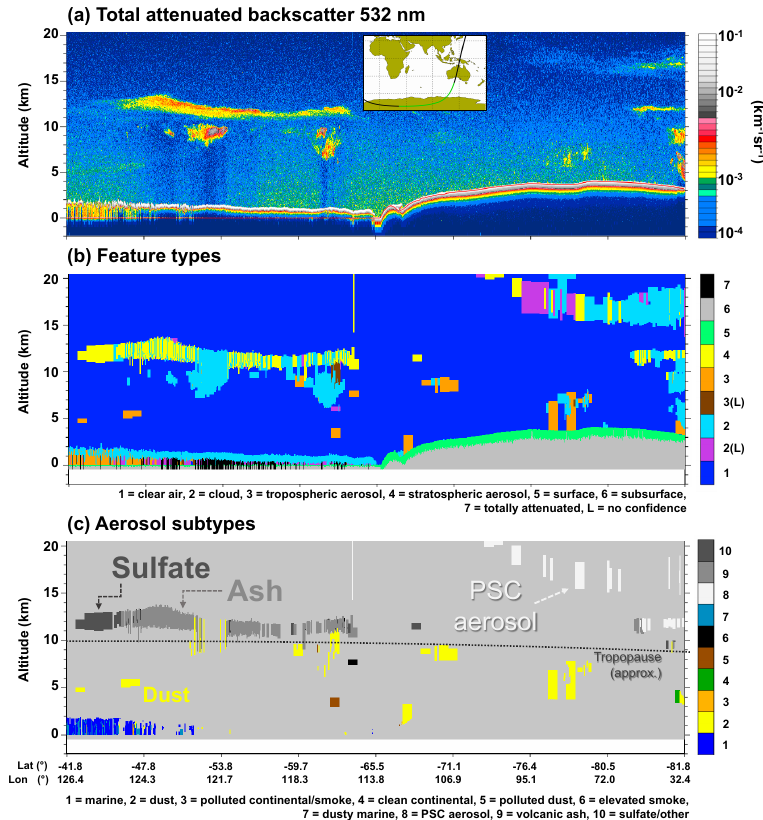
Figure 7. CALIOP observations of the Puyehue-Cordón Caulle volcano plume on 20 June 2011 between 16:50 and 17:00UTC. (a) Total attenuated backscatter at 532nm, (b) V4 feature type classification, and (c) V4 aerosol subtypes, where the dashed line indicates the approximate location of the tropopause. The satellite ground track is indicated by the green section on the inset map in panel (a) . Additional imagery for this scene, including 532nm depolarization ratios and attenuated backscatter color ra- tios, can be found at https://www-calipso.larc.nasa.gov/products/lidar/browse_images/show_detail.php?s=production&v=V4-10&browse_ date=2011-06-20&orbit_time=16-22-13&page=3&granule_name=CAL_LID_L1-Standard-V4-10.2011-06-20T16-22-13ZN.hdf (last ac- cess: 26 September